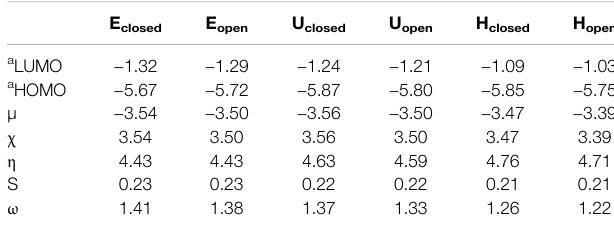
TABLE 1 | HOMO and LUMOenergiesand globalreactivity descriptors (eV) ofthe conformers of anandamide obtained at the BP86/cc-pVTZ level of theory in chloroform.